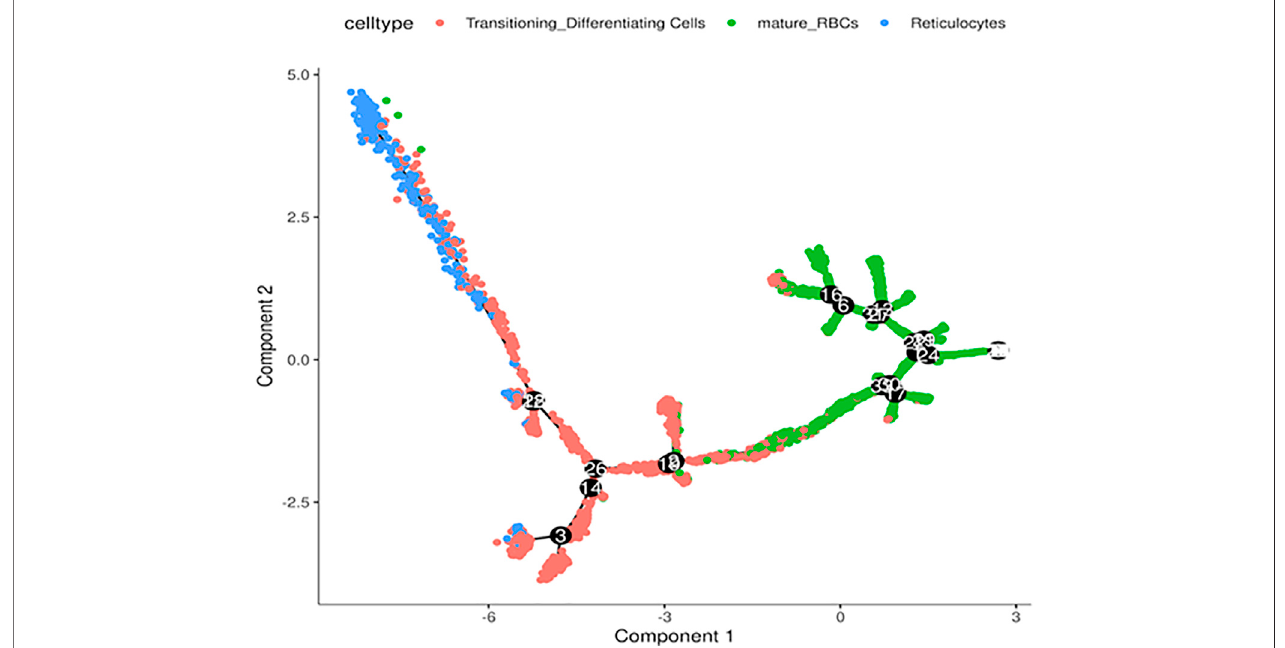
FIGURE 4 | Trajectory analysis of differentiating RBCs. In silico analysis of differentiating RBC from reticulocytes to transitioning cells and mature RBCs colored